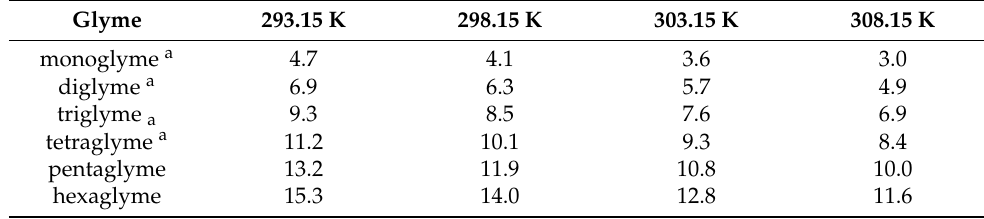
Table 3. Standard isobaric molar thermal expansion of glymes in the DMF + W mixture.